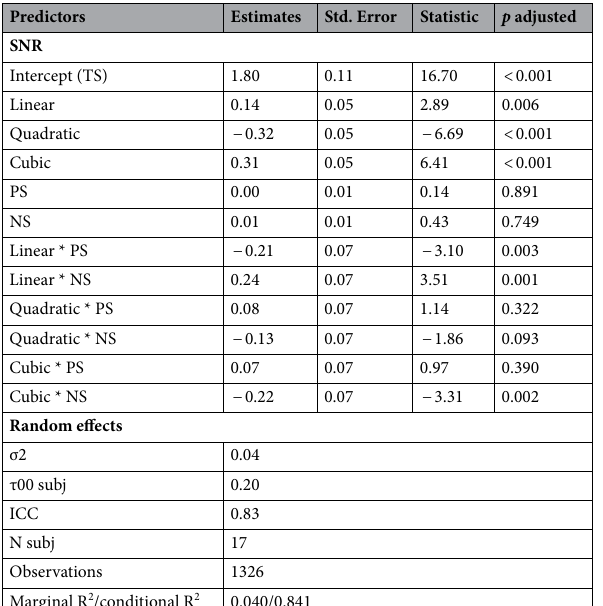
Table 1. Final model parameters for stems. Factors were dummy coded with truly suffixed as reference level, using polynomial interpolation. The b -coefficient (estimates) represents the adjustment with respect to the reference level. TS truly suffixed, PS pseudo-suffixed, NS